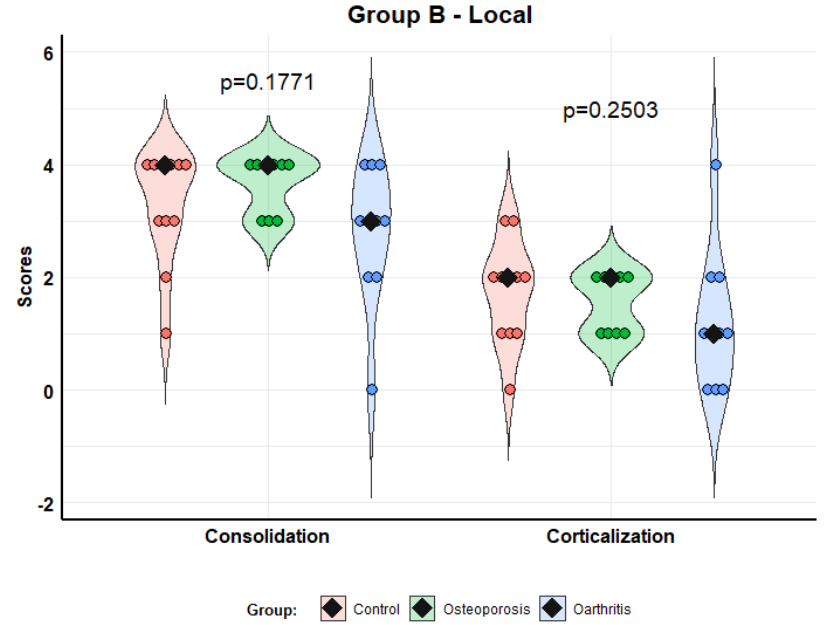
Figure 4. Scores of consolidation and corticalization in model B (local administration). Violin plots with individual values and medians (rhombi).